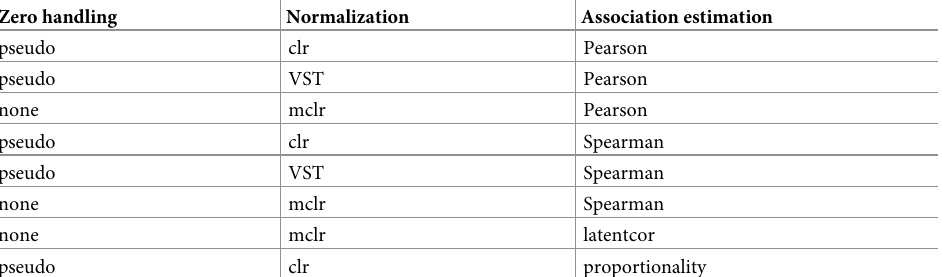
Table 5. Method combinations for generating microbial associations, which are then transformed into (dis)simi- larity matrices. The (dis)similarity matrices were used as input for hierarchical and spectral